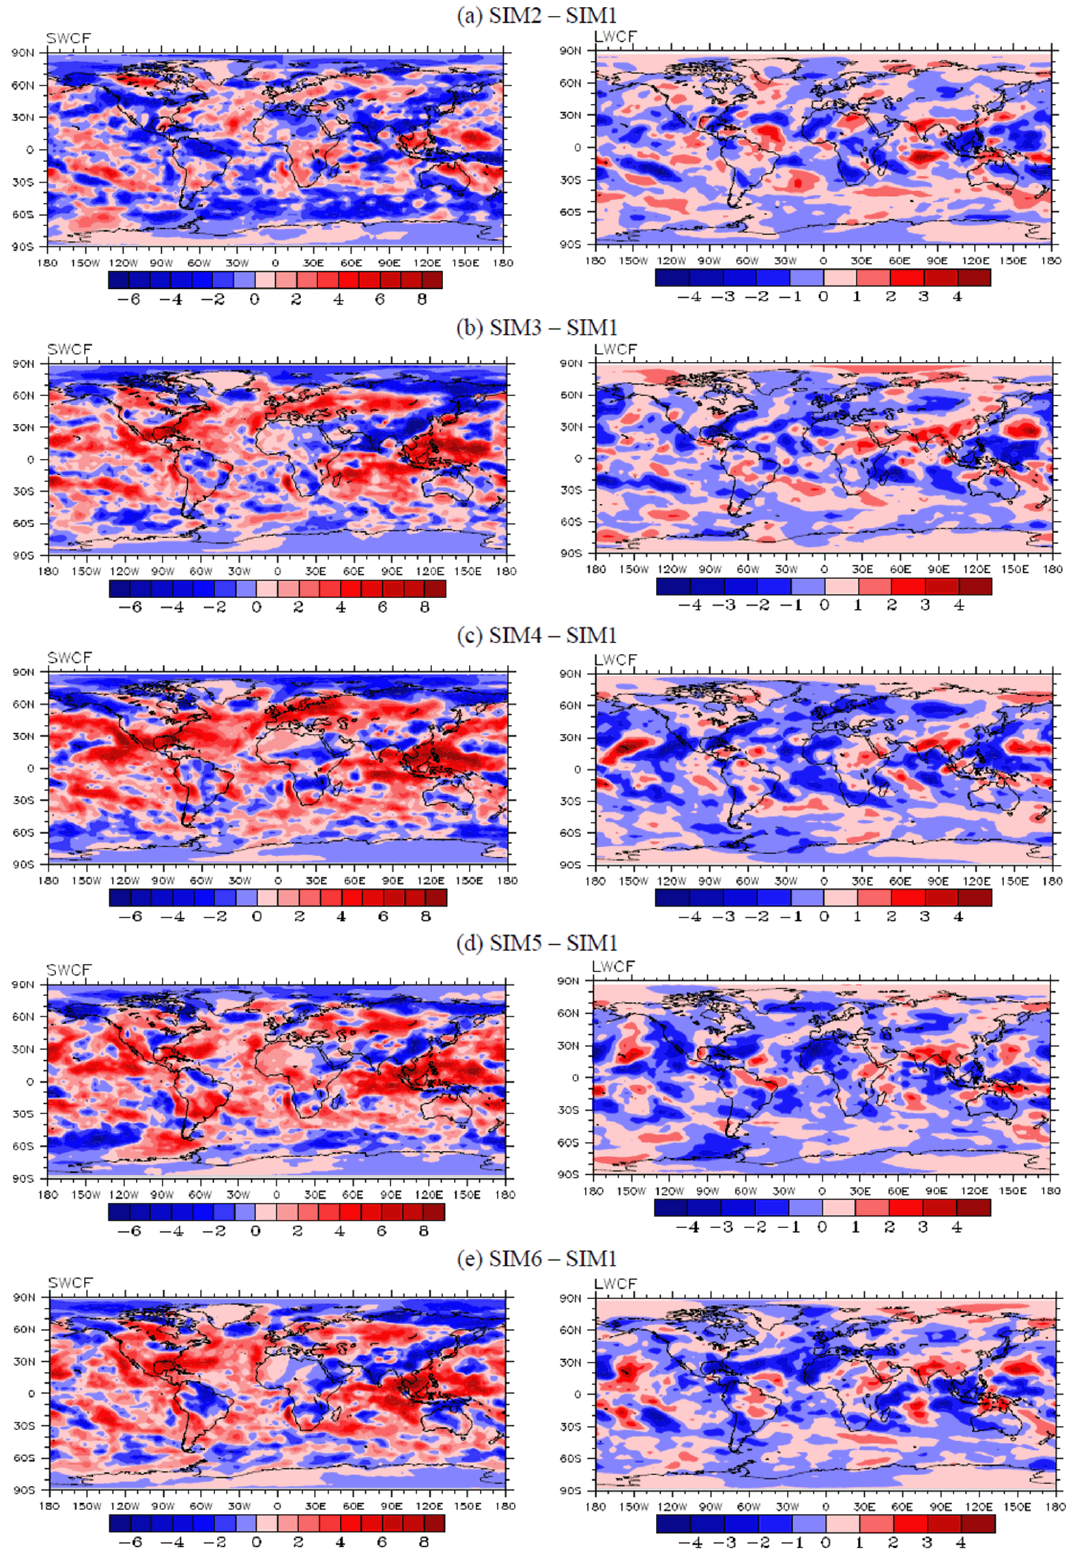
Figure 6. Global distributions of difference in simulated annual mean SWCF and LWCF (units: Wm − 2 ). (a) SIM2–SIM1, (b) SIM3–SIM1, (c) SIM4–SIM1, (d) SIM5–SIM1, and (e)